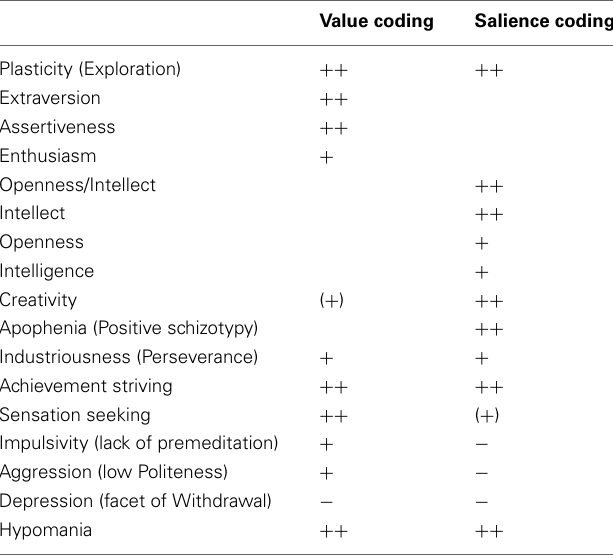
Table 2 | Traits hypothesized to be related to the value coding and salience coding dopaminergic